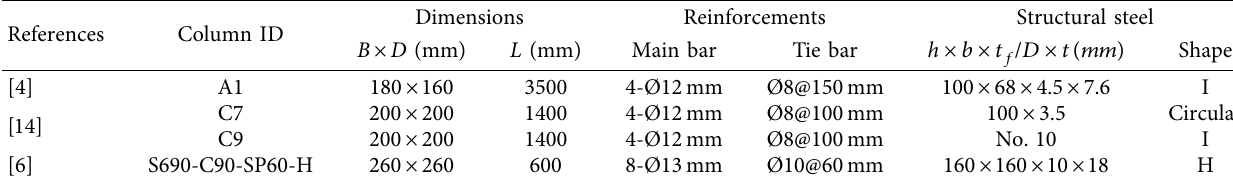
Table 8: Geometrical properties of selected FEC test columns for